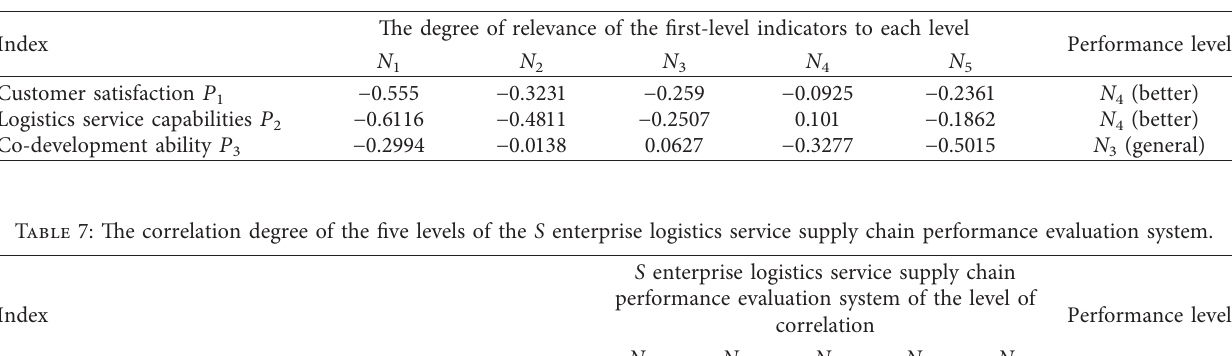
Table 6: The correlation between the five levels of the first-level indicators of the S enterprise logistics service supply chain performance evaluation system.